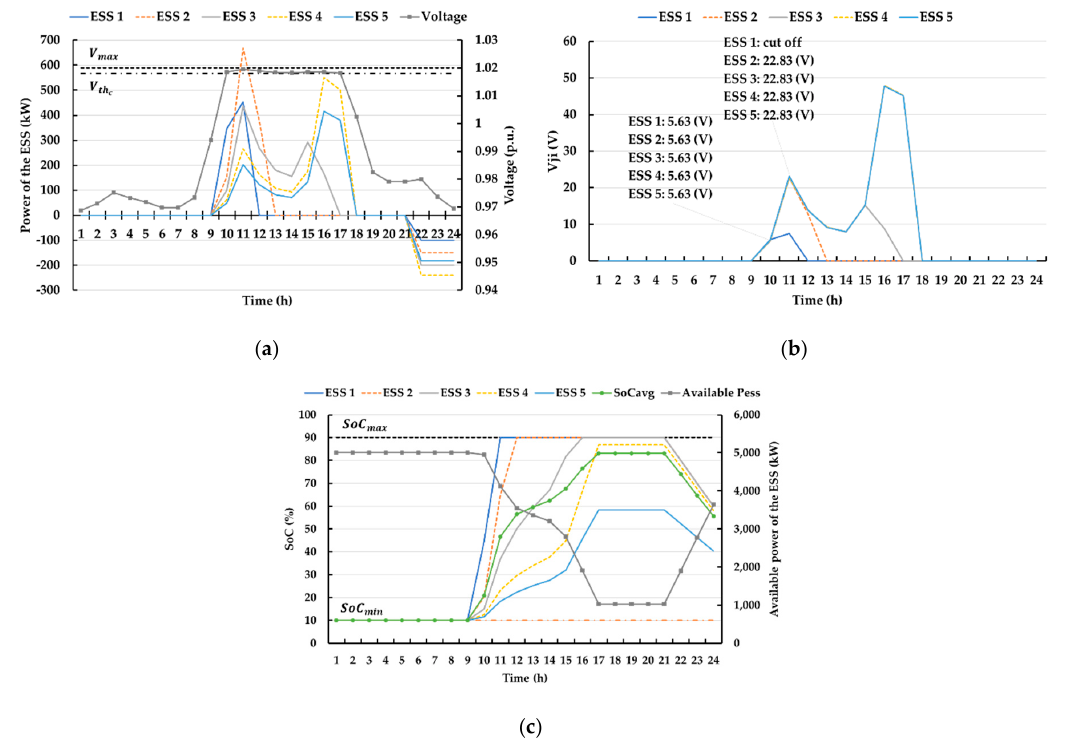
Figure 13. Voltage control results without ε,μ : ( a ) Voltage profile and power of the distributed ESS; ( b ) 𝑉 (cid:3037)(cid:3036)(cid:3047) ; ( c ) SoC profile.